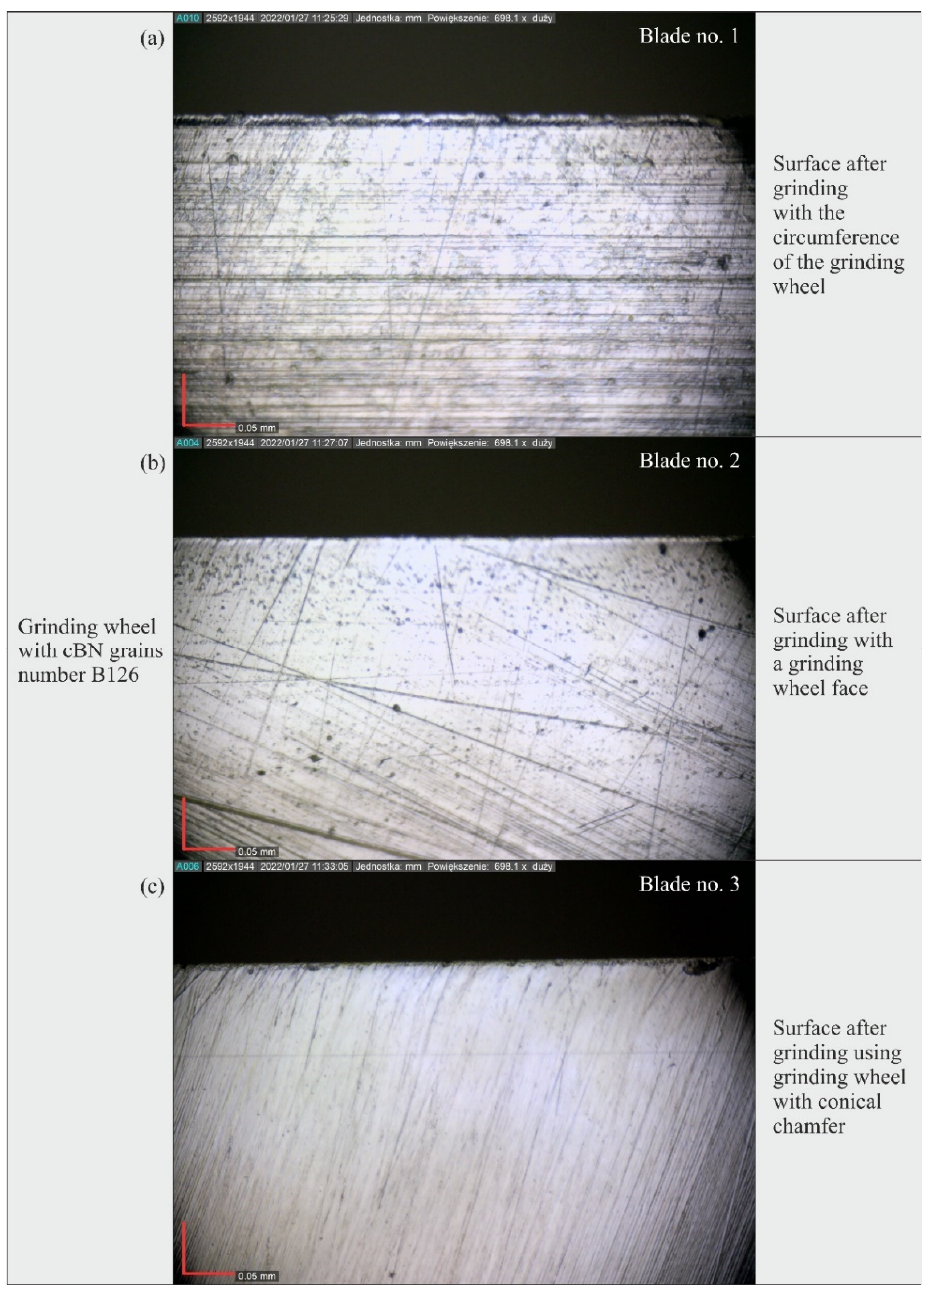
Figure 19. Microscopic views of the blade surface of planar knives shaped using grinding wheels with cBN abrasive grains numbered B126 at a magnification of approximately 700×: ( a ) surface after peripheral grinding (blade no. 1); ( b ) surface after face grinding (blade no. 2); ( c ) surface after grinding using grinding wheel with conical chamfer (blade no.